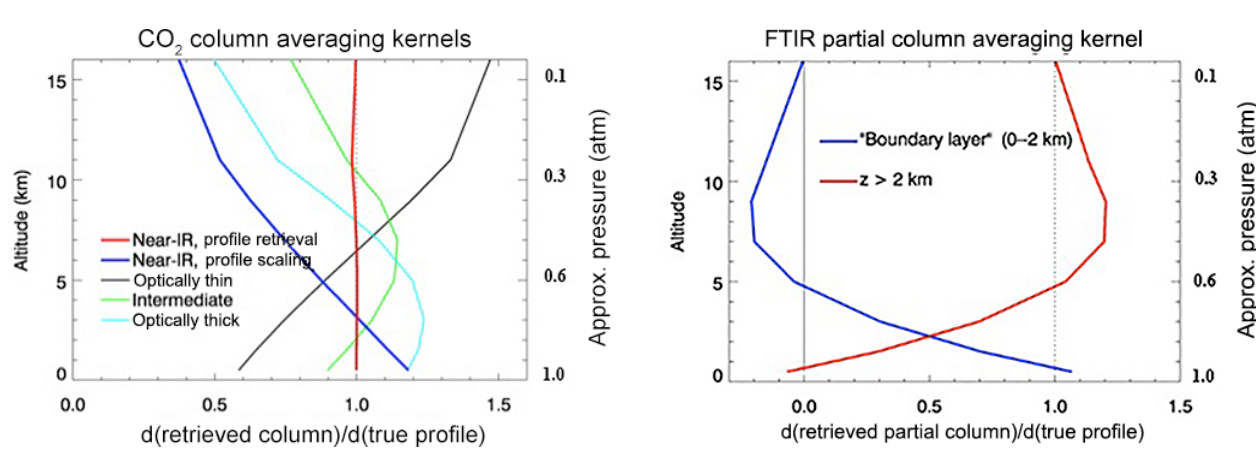
Figure 1. Column averaging kernels for simulated retrievals. “Pro- file retrieval” and “profile scaling” refer to a typical retrieval using GFIT2 on the 6220cm − 1 CO 2 band observed operationally. “Op- tically thin”, “optically thick”, and “intermediate” refer to an ide- alized, single, isolated spectral line. For these, we calculate a spec- trum from a reference profile, perturb the profile at a single altitude, and calculate a new spectrum. We then perform a least-squares fit to this synthetic spectrum by deriving a scale factor for the refer- ence profile. This scale factor, divided by the actual perturbation, produces a single element of the column averaging kernels shown.